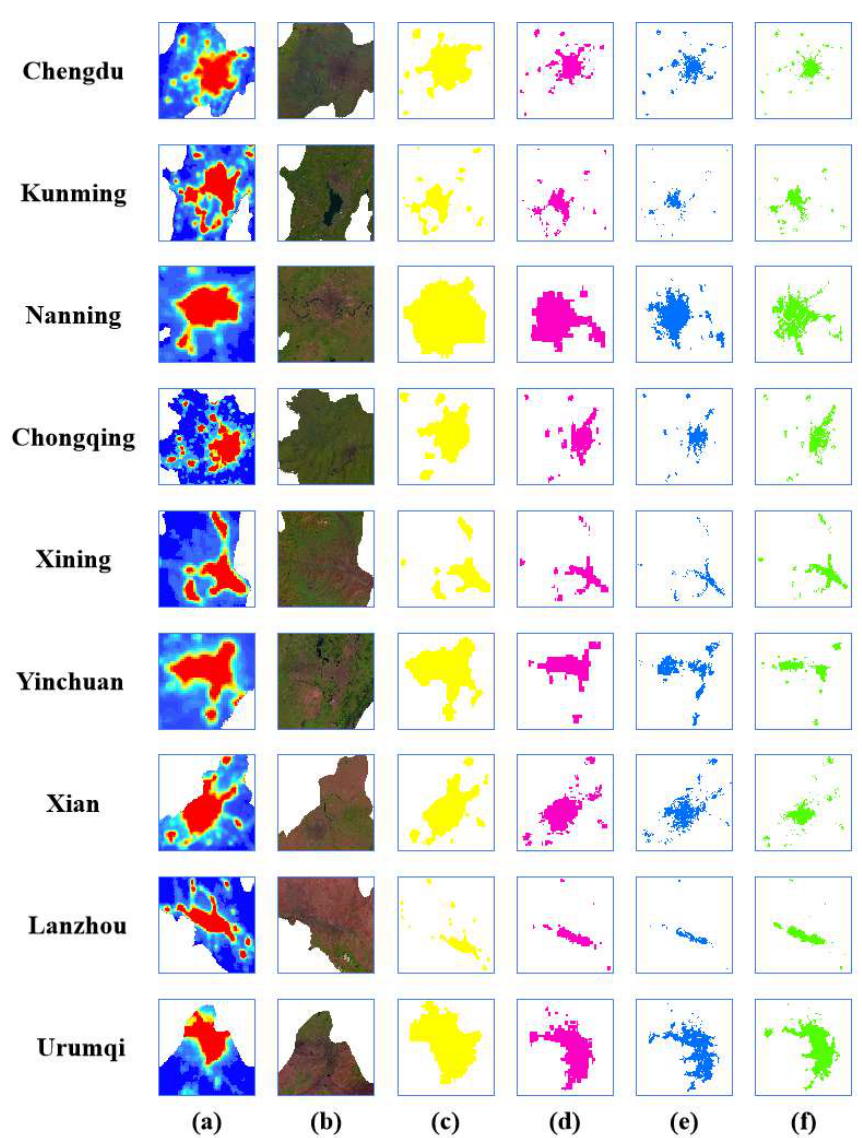
Figure 7. Results of built-up area extraction in 2010 by the proposed approach and several reference methods. ( a ) The Defense Meteorological Satellite Program-Operational Linescan System (DMSP-OLS) image; ( b ) the Landsat 7 ETM + image; ( c ) the threshold dichotomy method; ( d ) the improved neighborhood focal statistics (NFS) method; ( e ) the proposed method; ( f ) the ETM + fusion image